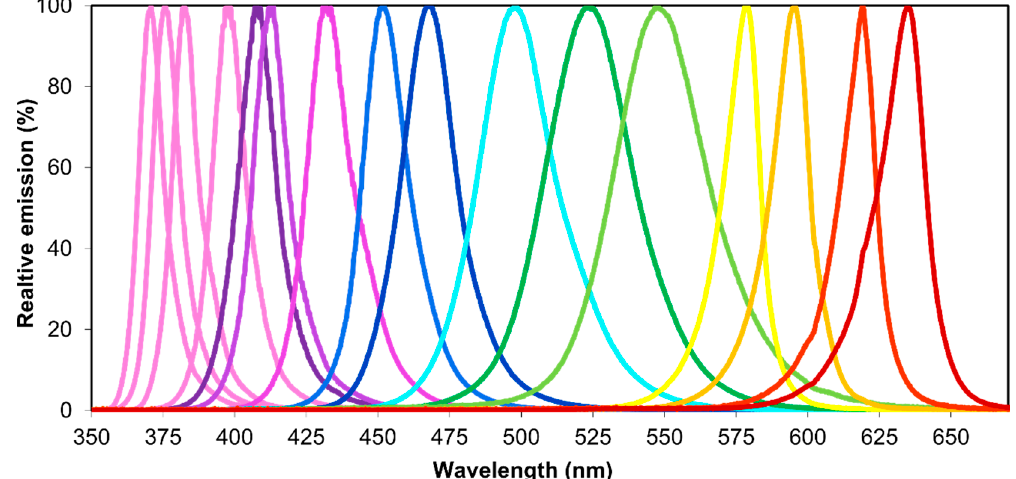
Figure 2. Spectra of high-power light-emitting diodes (LEDs) used. See Table 1 for specifications. 2.5. Attractiveness of Different Wavelengths from the Ultraviolet to the Visible Spectral Range (307–635 nm) Two experiments were conducted. While six color traps (UVA1, Blue2, Cyan, Green1, Yellow2, Red) were used in the first experiment, the blue LED (476 nm) was excluded in the second experiment to narrow down the attractiveness of the spectral range. All LEDs were adjusted to the intensity of the color trap Cyan (41.2 µmol m − 2 s − 1 ) in both sections. Twenty consecutive replicates were performed respectively.